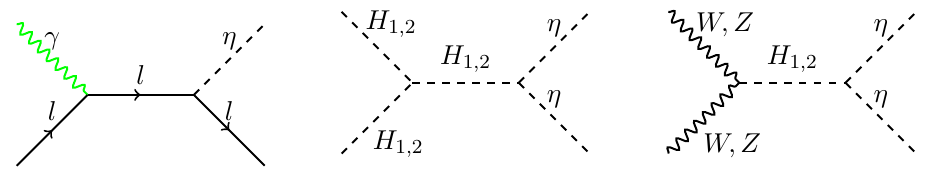
i (cid:24) 1 =s (cid:24) T (cid:0) 2 . (cid:11)x ! (cid:17)y